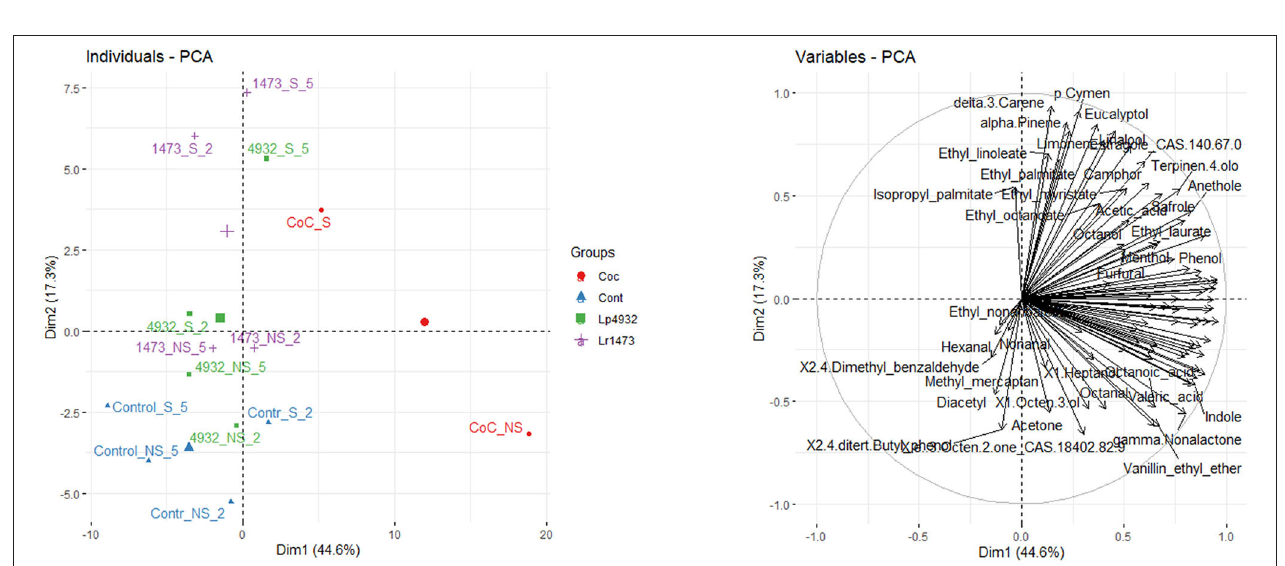
FIGURE 8 | Principal component analysis plot of the similarities and differences in the sensory profiling characteristics of exhausted vanilla beans prepared follow the condition n.5 of DoE and co-cultures.CC, co-culture; LP, Lactiplantibacillus plantarum 4932; LR, Lacticaseibacillus rhamnosus 1473; Control, unfermented samples. S: sample with seeds; NS: sample without seeds.